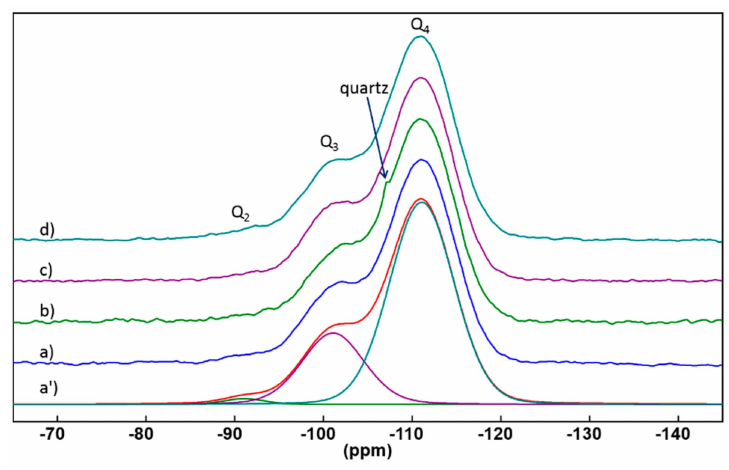
Figure 3. The 29 Si solid state nuclear magnetic resonance (NMR) spectra of the four samples ( a ) PETRO (number of scans = 1192); ( b ) GEODIA (number of scans = 960); ( c ) APHRO (number of scans = 1277) and ( d ) LAOCO (number of scans = 1080). For all spectra, the recycling delay was 60 s at 45 ˝ pulse.